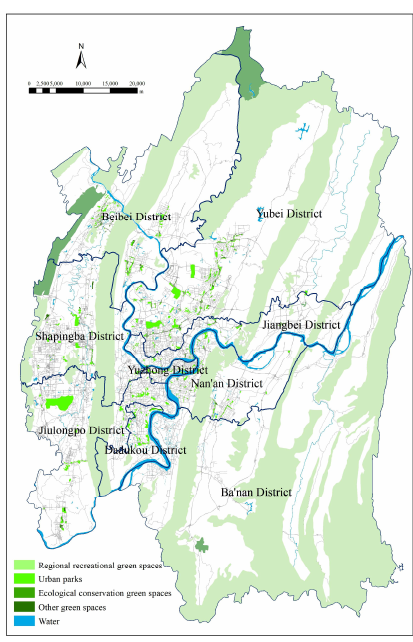
Figure 3. The current urban green spaces.